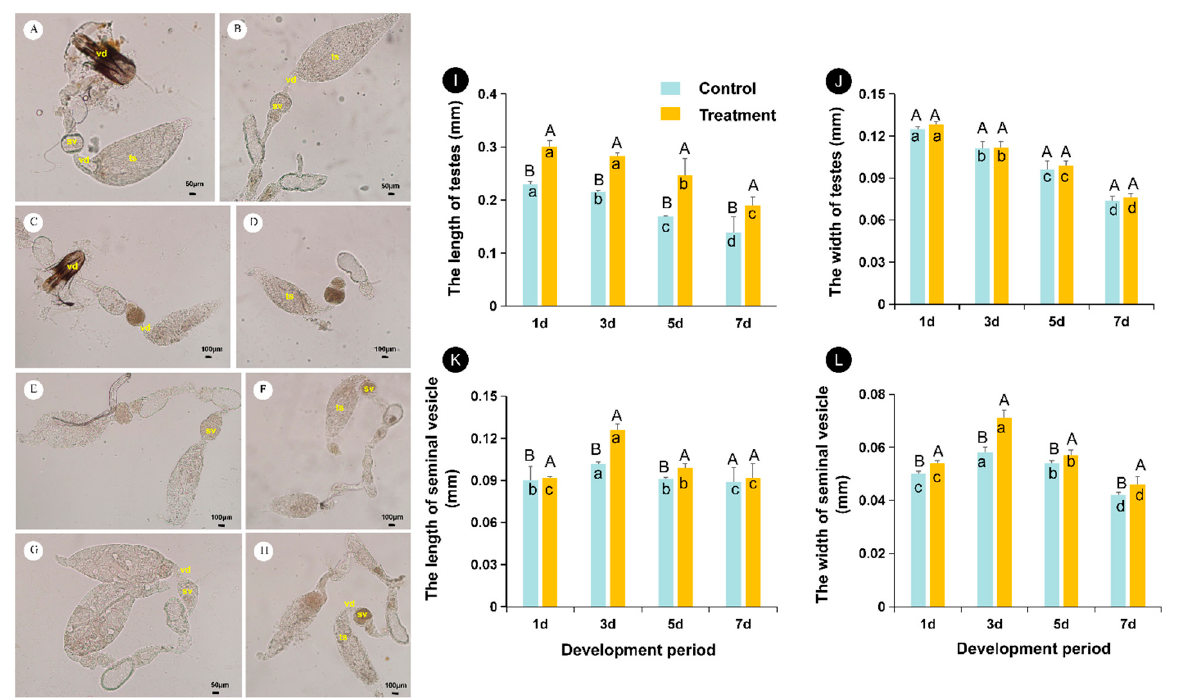
Figure 3. Morphology and developmental dynamics of Aenasius bambawalei testes at different temperatures. ( A , C , E , G ) rep- resent the morphology of testes from control males at the early stage (1 day after emergence), middle stage i (3 days after emergence), middle stage ii (5 days after emergence), and final stage (7 days after emergence), respectively; ( B , D , F , H ) repre- sent the morphology of testes from heat-treated males at the early stage (1 day after emergence), middle stage i (3 days after emergence), middle stage ii (5 days after emergence), and final stage (7 days after emergence), respectively. In ( I – L ), the different uppercase letters indicate that there is a significant difference between the high temperature treatment and the control, while the different lowercase letters indicate that there is a significant difference at different development periods. Ts—testis, vd—vas deferens, sv—seminal vesicle, ed—ejaculatory duct. Bars A–F, H indicate 0.1 mm, and bar G indicates 0.05 mm.